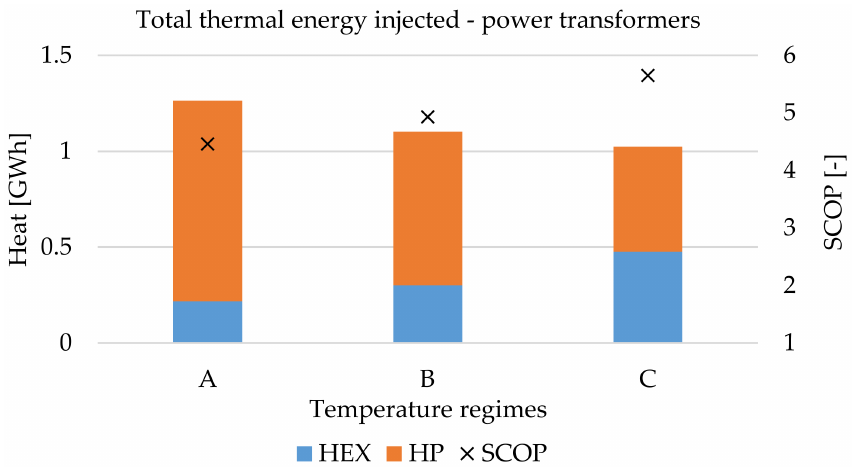
Figure 19. Seasonal COP and total power substation waste heat utilized in relation to different DH network temperature regimes, for the selected connection pipe